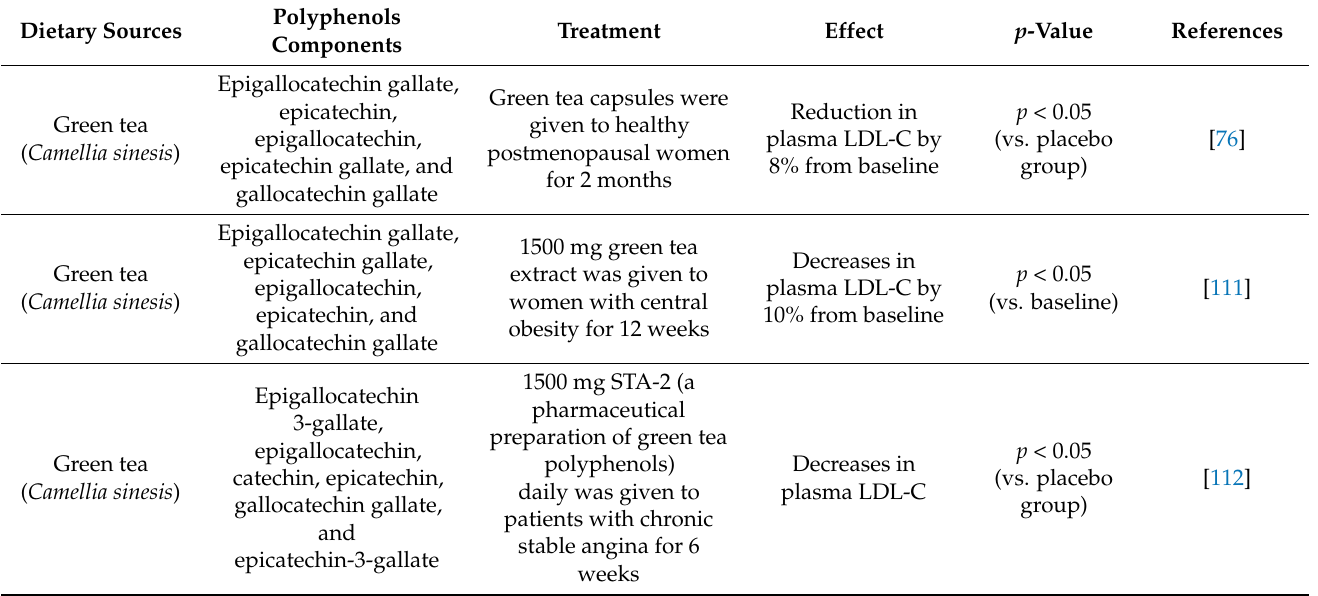
Table 3. Dietary sources, polyphenols, and cholesterol-lowering activities in clinical